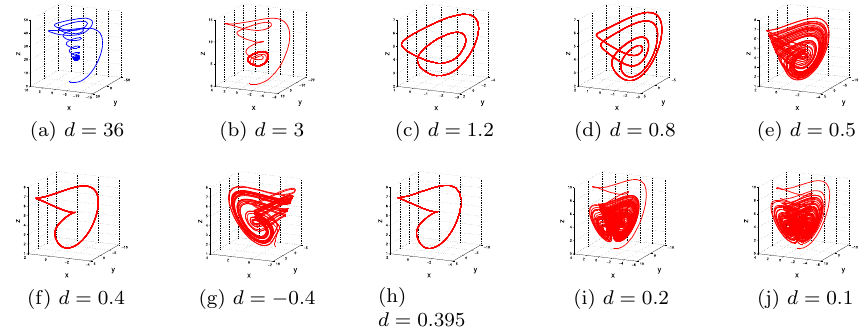
Figure 2. The phase portraits of system (2.3) when the parameters ( a,b,c ) = (2 , 3 , 0 . 8) and d varies and the initial condition ( x 0 ,y 0 ,z 0 ) = (3 . 82 × 1 e − 5 , 6 . 18 × 1 e − 5 , 0). These figures display the evolution process of chaotic attractors of system